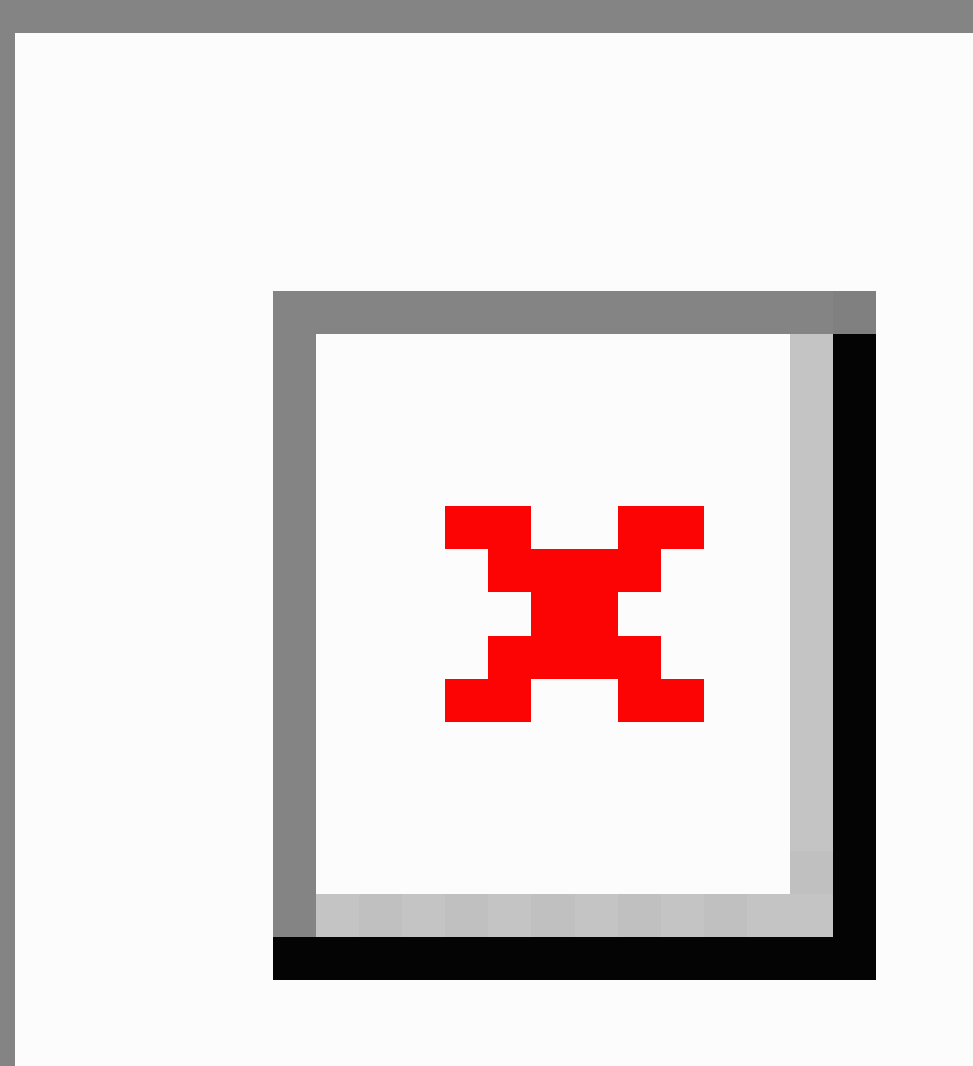
corner of the frame, and the time remaining, the pause button, and the full screen activation button appear on the upper right hand corner. The lower left hand corner shows the level indicator and the bottom right the answer indicator (right and wrong) (Figure 5). The bottom of the screen displays 2 buttons: (1) the instructions button, which enables the patient to review the instructions even during the exercise and (2) the fatigue button (designated, skip game button), which can be activated if the patient feels tired or discouraged with a specific game. The pause button allows the session to be stopped in case of unforeseen events that might distract the patient and hinder the performance. This button should be used